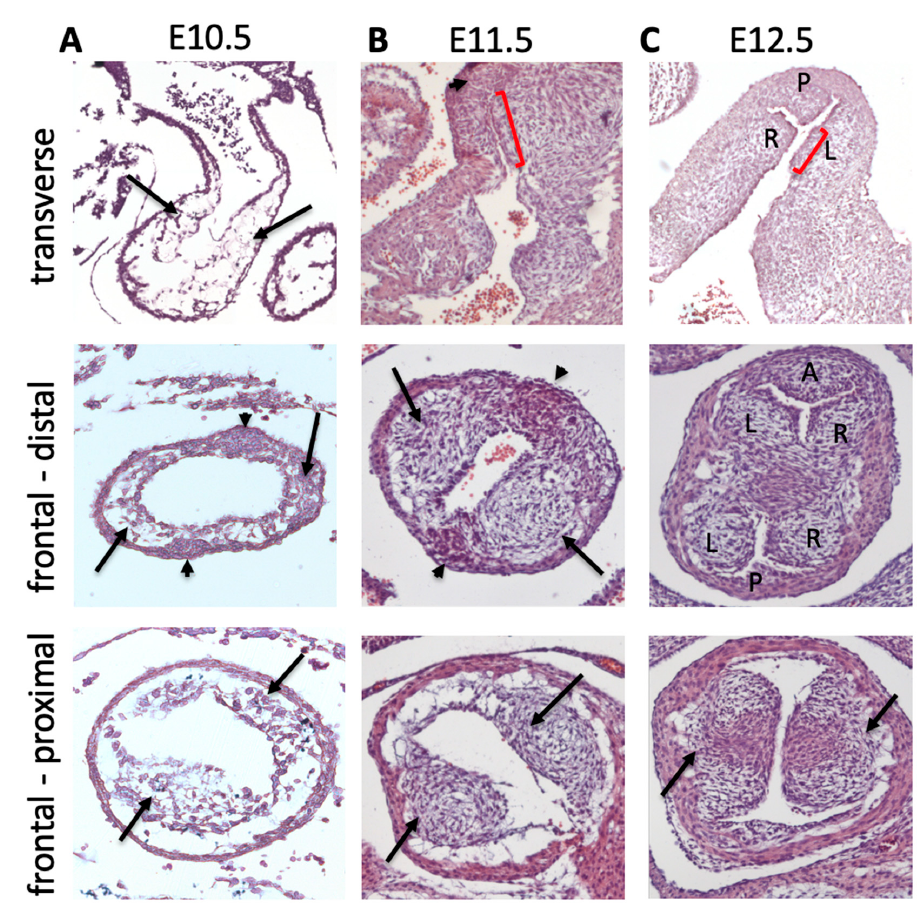
Figure 4. Contributions of the cushions and ICVS to the arterial valve primordia. Histological sections of mouse hearts stained with H&E. ( A ) At E10.5 the outflow is unseptated. The cushions (arrows) are forming and can be seen to extend along the length of the outflow tract in transverse view and to be circumferential in both the distal and proximal regions, in frontal view. The ICVS cannot be seen in transverse sections at this stage, but in frontal sections can be seen distally as cell dense regions within the outflow wall (arrowheads). ( B ) By E11.5, the cushions are more cell dense and in transverse sections the valve forming part (red bar) can be seen to be distinct from the proximal part of the cushions that will form the sub-pulmonary infundibulum in transverse sections. The ICVS (arrowhead) can now be seen adjacent to the valve-forming parts of the cushions. In frontal sections the main cushions (arrows) are coming together towards the midline of the outflow tract in the distal region. The ICVS (arrowheads) have expanded but are still continuous with the outflow wall. More proximally, the cushions (arrows) are still widely separated . ( C ) By E12.5 the outflow tract has septated and the primordia of all three leaflets are apparent in transverse and frontal views. The proximal region of the outflow tract remains unseptated at this time point, although the cushions (arrows) are beginning to come together. A = anterior leaflet; L=left leaflet; P = posterior leaflet; R = right leaflet.